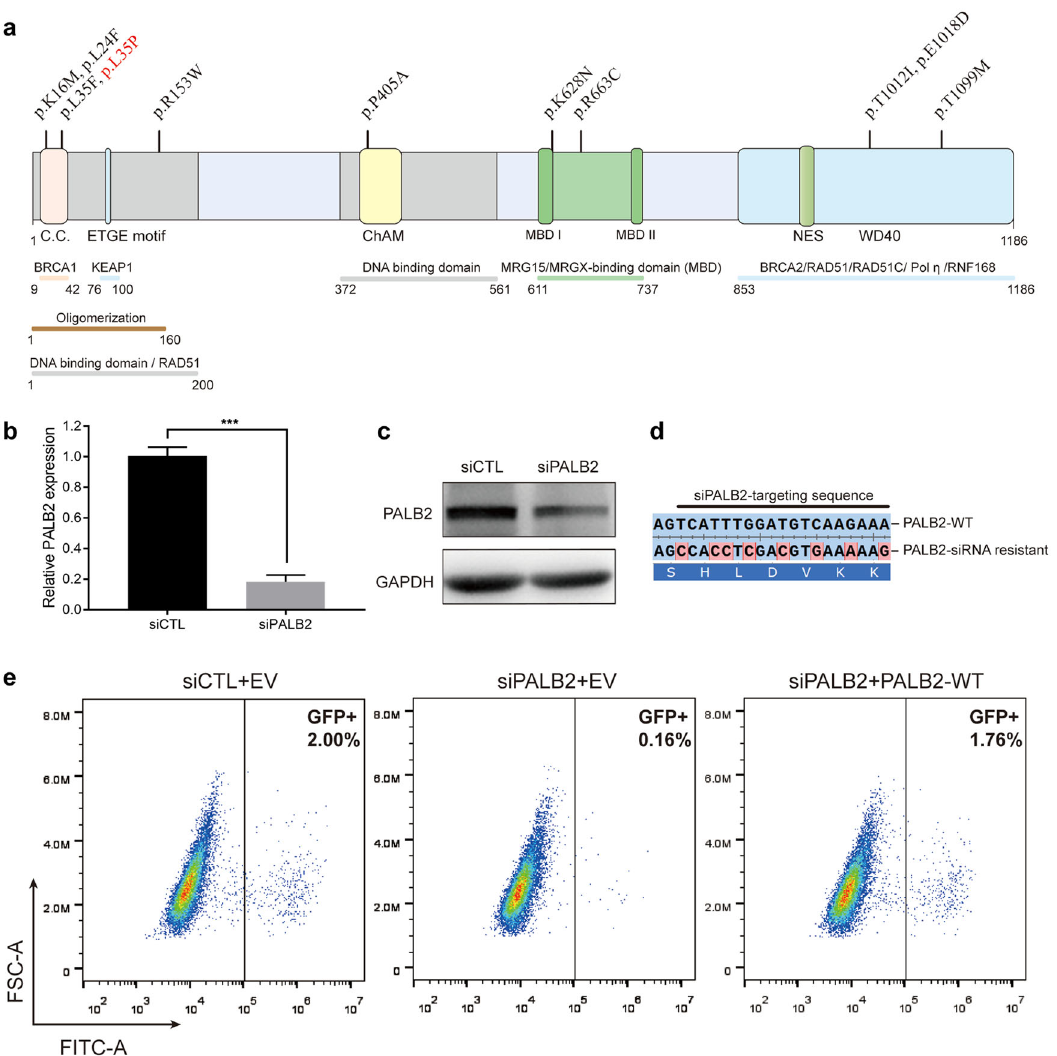
Fig. 1 Overview of PALB2 VUSs examined in our study and validation of the U2OS/DR-GFP homologous recombination (HR) reporter system. a Schematic representation of the PALB2 protein and the position of the previously identi fi ed PALB2 VUSs. The p.L35P pathogenic variant was also included and highlighted in red. C.C., coiled-coil domain; ChAM, chromatin-association motif; WD40, WD40-repeats; NES, nuclear export sequence. b , c siRNA-mediated knockdown ef fi ciency of endogenous PALB2 in U2OS/DR-GFP cells was evaluated by quantitative PCR and western blotting. Data represent the mean percentage (± SEM) of PALB2 mRNA relative to siCTL from three independent experiments. Statistical signi fi cance was analyzed by Student ’ s t -test. *** P < 0.001. d Schematic representation of the siRNA-resistant PALB2 cDNA containing eight silent base changes. e Representative plots for the HR activity of PALB2. The HR activity of U2OS/DR-GFP cells was fi rst deprived after siRNA knockdown and then rescued with the siRNA-resistant PALB2-WT construct by transient transfection. GFP-positive cells were quanti fi ed by fl ow cytometry. EV Empty vector, WT Wild